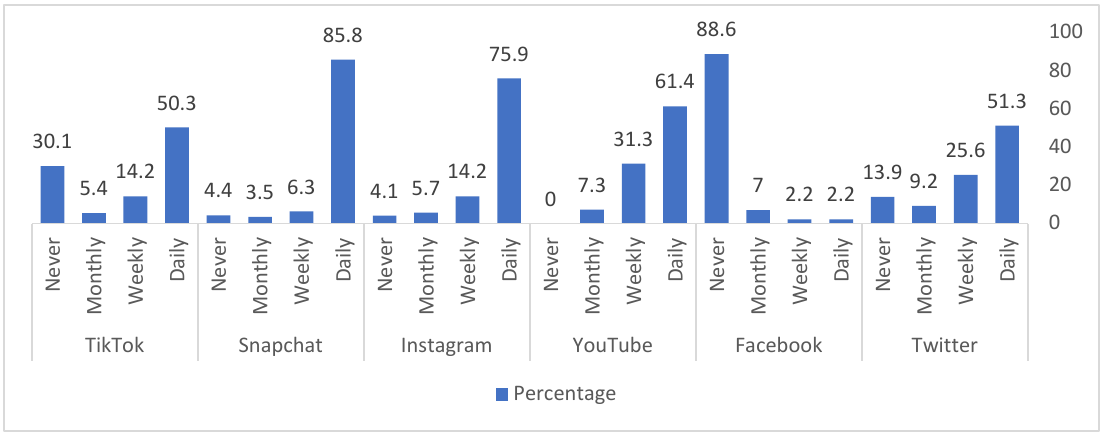
Figure 1. The percentage of the use of social media platforms among the study participants. Table 2. Frequency of social media platform usage among the study participants according to their obesity status.